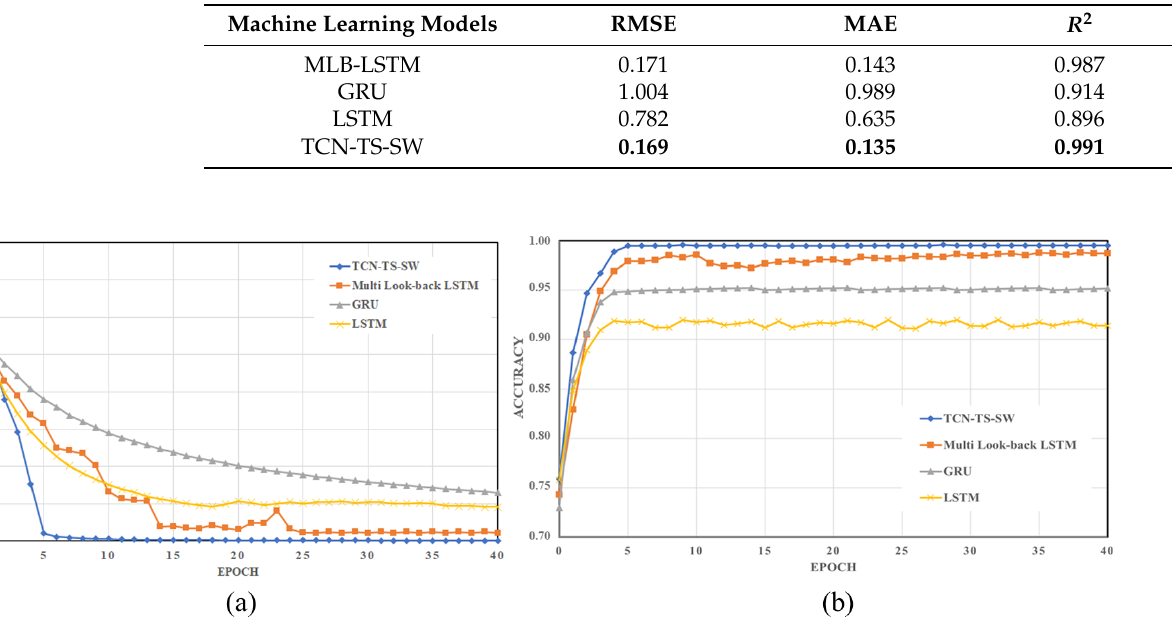
Figure 4. The performance of TCN-TS-SW against the multi look-back LSTM, GRU, and LSTM. ( a ) Time-series training loss over epoch. ( b ) Time-series training accuracy over